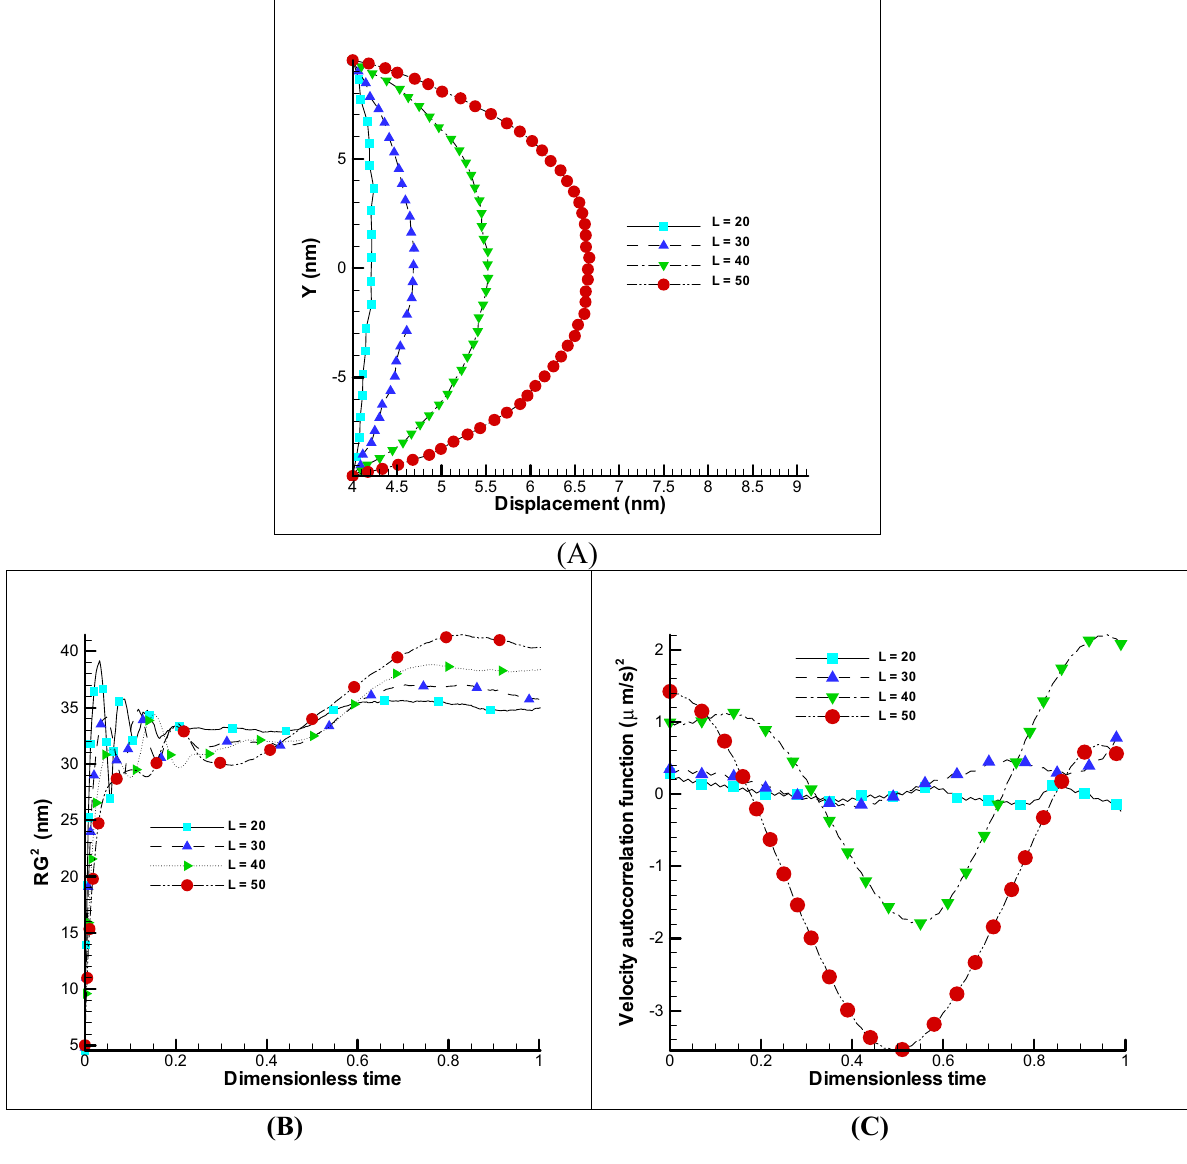
Figure 8. Effect of number of beads on membrane. Displacement of polymer chain in EOF for different beads number ( A ). Changes of radius of gyration and VACF over dimensionless time (t/t max ) considering different beads number ( B , C